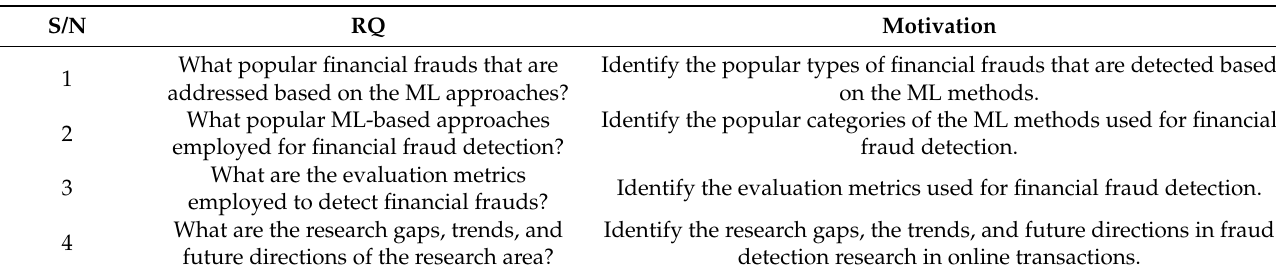
Table 1. Research Questions.